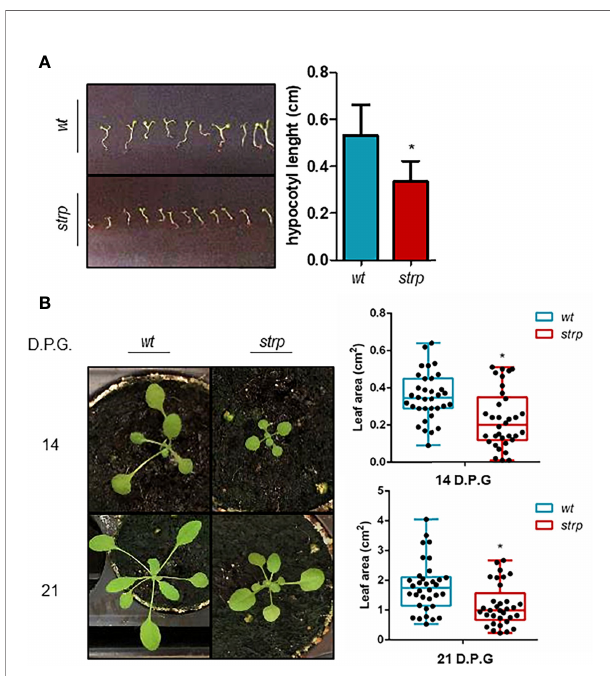
FIGURE 4 | Phenotypical characterization of strp mutant. (A) hypocotyl length of one-week-old seedlings. Hypocotyls were measured by using ImageJ (Schneider et al., 2012). (B) rosette leaf area of plants grown for one, two or three weeks in universal soil. Rosette area was determined with EasyLeaf area software (Easlon and Bloom, 2014). D.P.G., days post- germination. Error bars are S.E.M. of four independent experiments. *P < 0.01, by Student ’ s